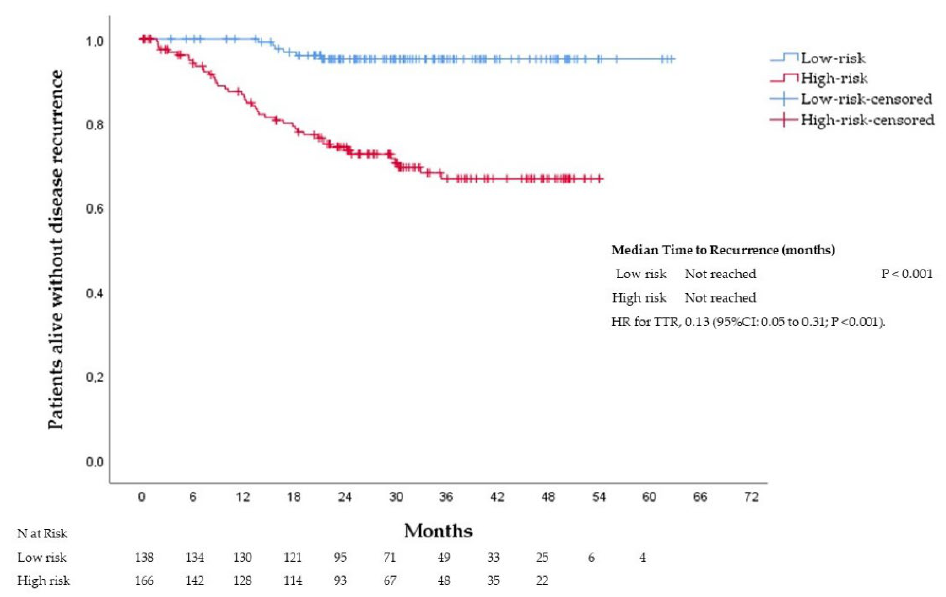
Figure 2. Time to recurrence according to the score (0–4) in the training cohort.